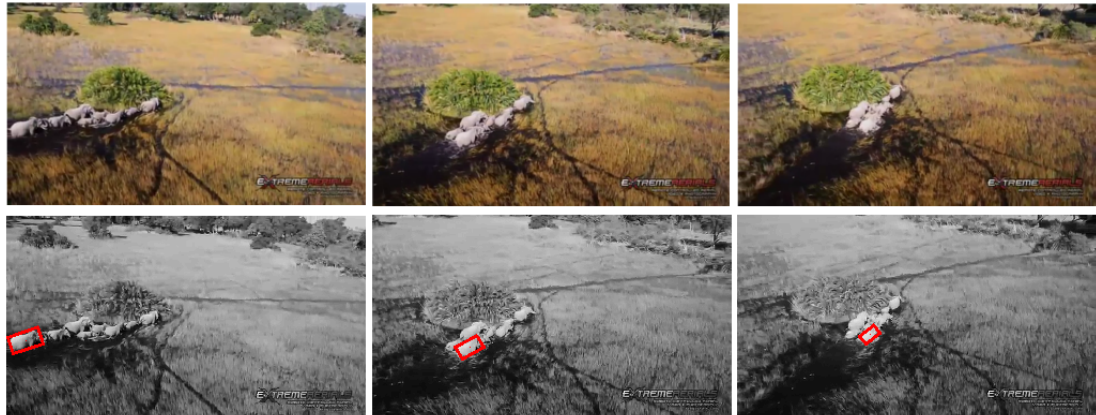
Figure 7. Visual elephant tracking.